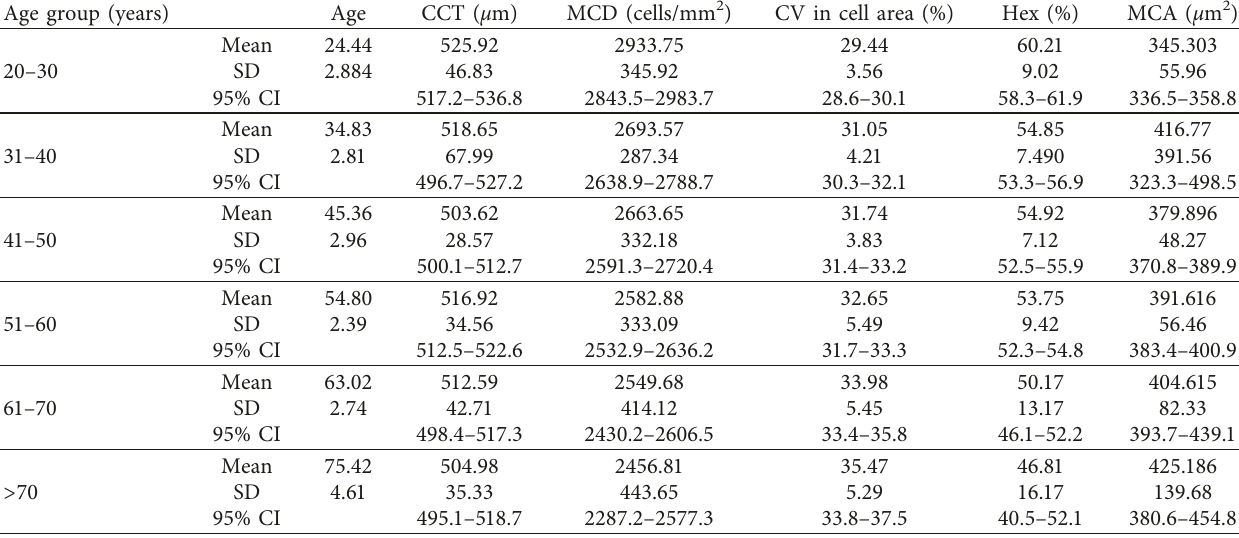
Table 4: Comparison of variables pertaining to the corneal endothelial cell density and morphology among different age groups of Egyptian subjects with healthy